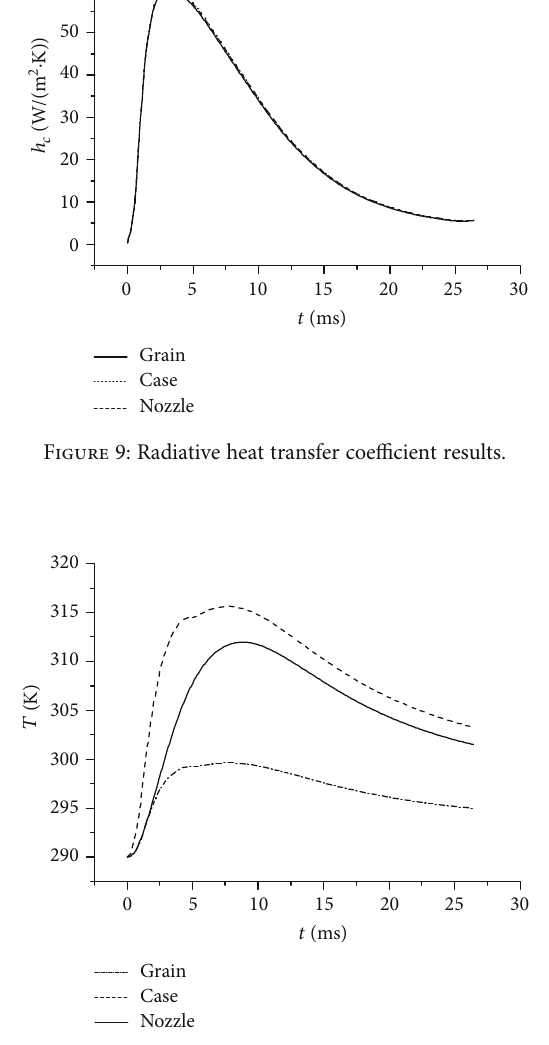
Table 3: Overall mass of the igniter gas computed in di ff erent cases. Cases